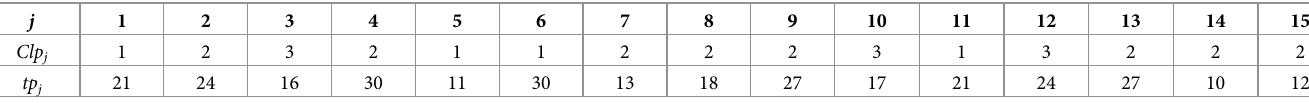
Table 3. Distribution of tp j for each packet Pt j for Example 2.